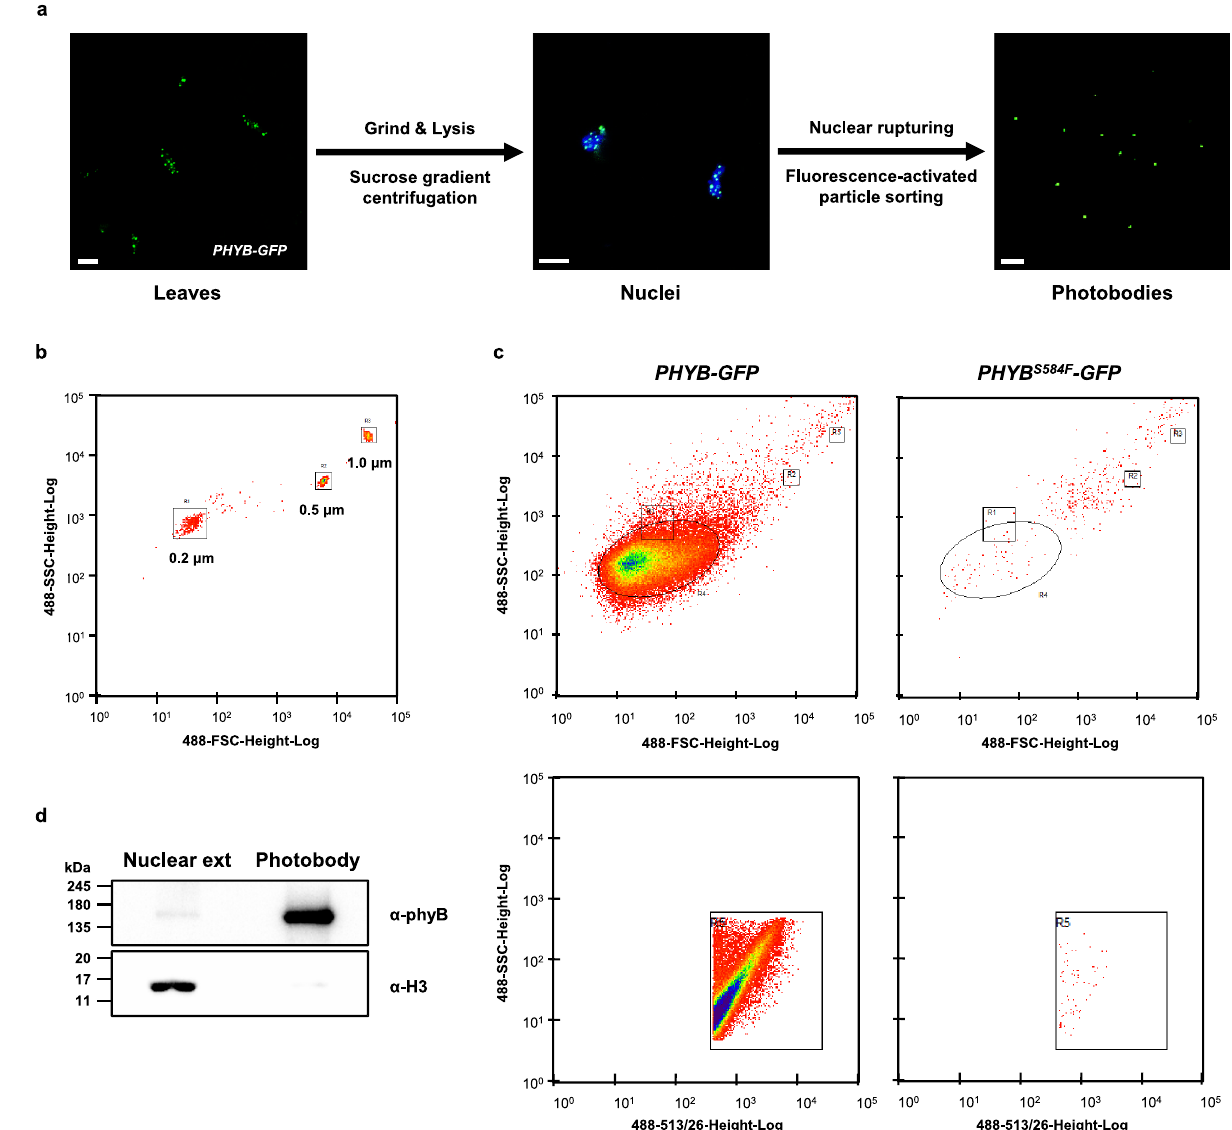
Fig. 1 | Isolation of phyB photobodies by fl uorescence-activated particle sort- ing. a The isolation scheme for phyB photobodies. Mature leaves of PHYB-GFP are sampled (left) and ground and nuclei are isolated by sucrose gradient centrifuga- tion (middle). The nuclei are ruptured by sonication and photobodies are isolated by fl uorescence-activated particle sorting (right). Images are captured under con- focal microscopy with (Nuclei) or without (Leaves, Photobodies) DAPI staining. Scale bars=10 μ m. b The forward and side-scatter parameters of 0.2-, 0.5-, and 1- μ m referencebeads (See Supplementary Fig. 1).The referencebeads weresorted to estimate the parameters for the phyB photobody. Each red dot indicates the positionofasortedreferencebeadandthemainpositionofeachreferencebeadis indicated by a square. c The determination of a scatter gate and FITC